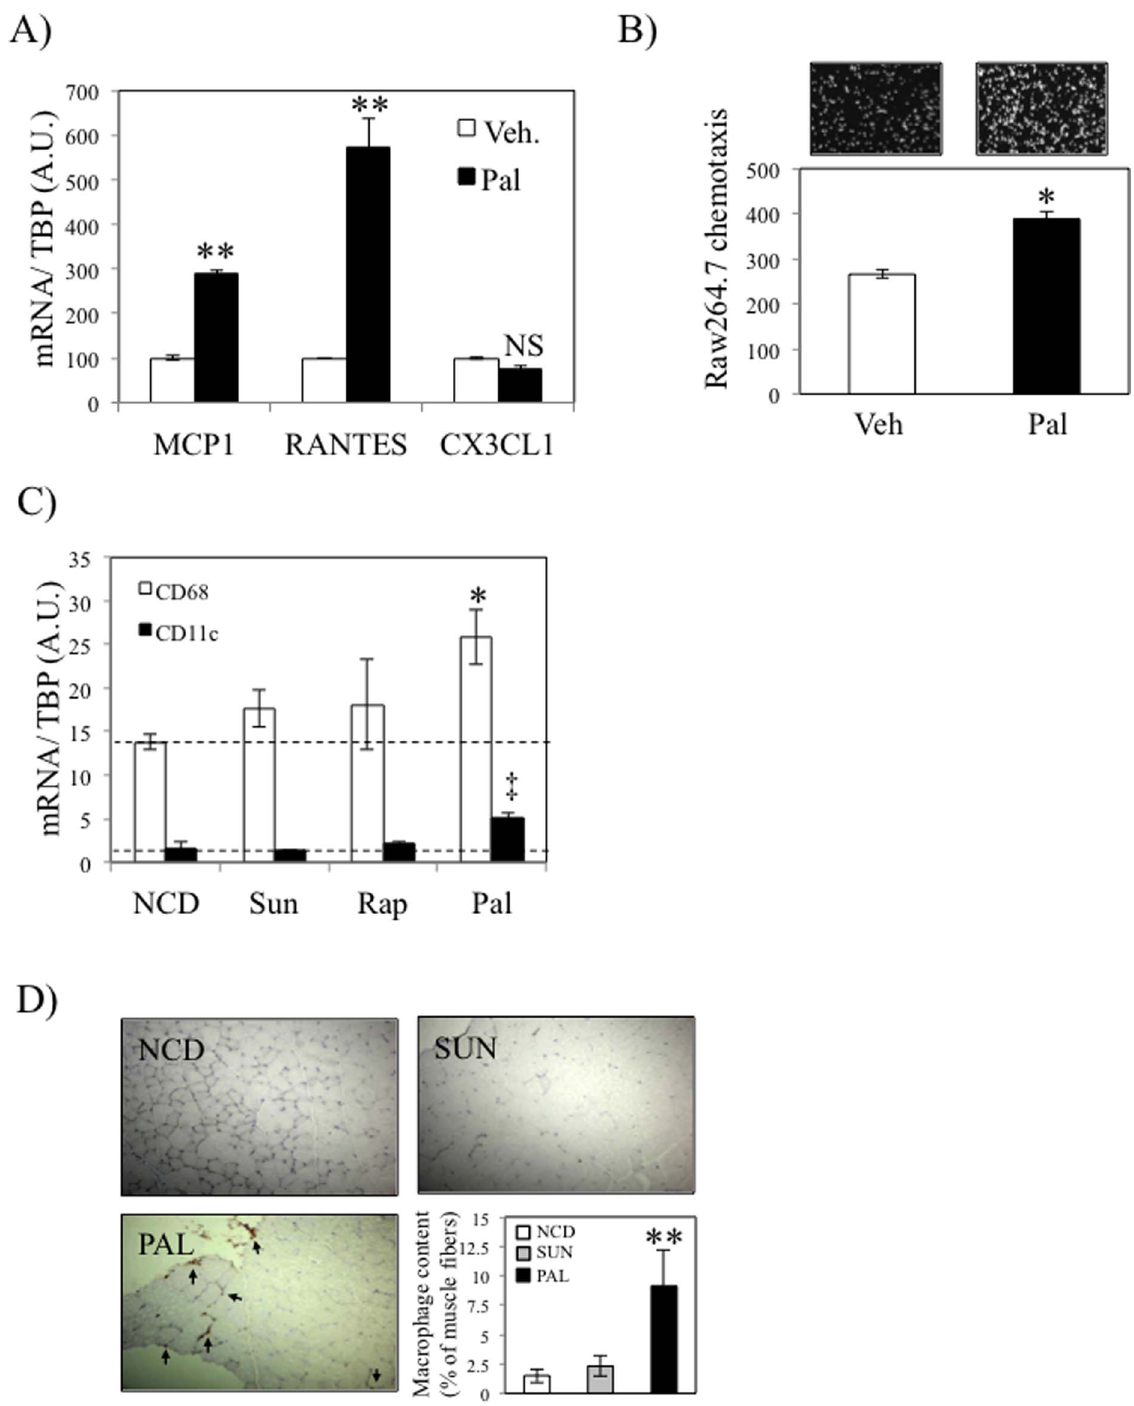
Figure 4. Palmitate induces macrophages recruitment by C 2 C 12 muscle cells. A) C 2 C 12 differentiated myotubes were exposed to palmitate (pal, 500 m M) or vehicle (BSA) for 24 hours. MCP1, RANTES and CX3CL1 expression were subsequently determined by real-time PCR. B) Conditioned media from C 2 C 12 cells treated as indicated in A) were collected and used for chemotaxis assay of Raw264.7 macrophages. Histogram represents the average number of Raw264.7 cells having performed chemotaxis. C) Wild-type C57Bl6 males were either fed a normal chow diet (NCD, low fat) or the same diet enriched with specific lipids sources (20% w/w. Sunflower (Sun), Rapeseed (Rap) and palm oil (Pal). CD11c and CD68 expression in gastrocnemius were subsequently determined by real-time PCR. D) F4/80 immunostaining was performed on muscle sections of mice either fed a normal chow diet, a Sunflower or a Palmitate enriched Diet. Macrophages quantification is shown in the lower right hand panel. In figure 4A, ** stands for P , 0.01 in palmitate vs vehicle condition. In figure 4C, * stands for P , 0.05 and ` for P , 0.01 for the respective comparison of CD68 and CD11c between Pal and NCD. NS, not significant; n=5.